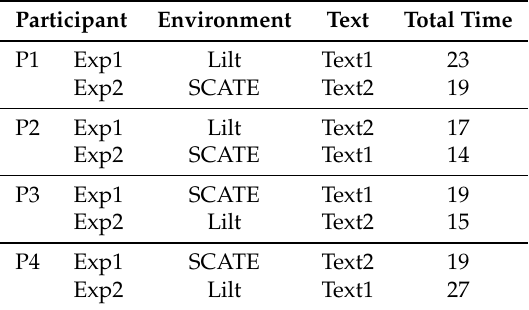
Table 2. Per participant, the order of the experiments, the environment used, the text that was translated and the total time expressed in minutes.